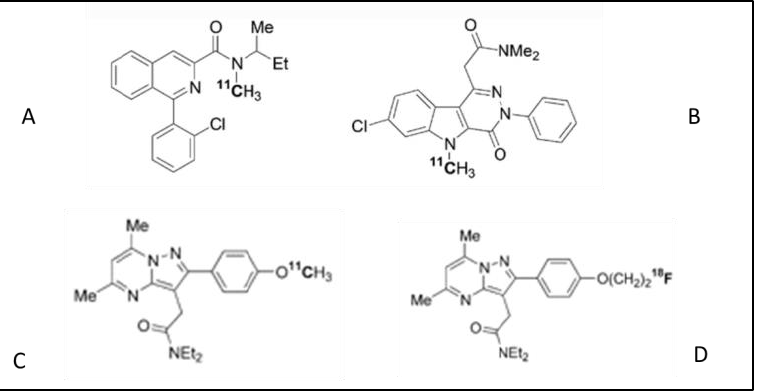
Figure 3. ( A ) 11 C-PK11195 (or [ 11 C]1), a component of the isoquinoline family; ( B ) indoleacetamide- derived 7-chloro-N,N,5-trimethyl-4-oxo-3-phenyl-3,5-dihydro-4H-pyridazino [4,5-b]indole-1-acetamide labeled with 11 C; ( C ) 11 C-labeled N,N-diethyl-2- [2-(4-methoxyphenyl)-5,7-dimethylpyrazolo [1,5-a]pyrimidin-3-yl] acetamide [ 11 C-DPA-713 ]; ( D ) 18 F-labeled N,N-diethyl-2-(2-(4-(2-fluoroethoxy)phenyl)-5,7-dimethylpyrazolo [1,5-a]pyrimidin-3-yl) acetamide ( 18 F-DPA-714 or 18 F [2]). DPA-713 and DPA-714 belong to the pyrazolopyrimidine acetamide family.